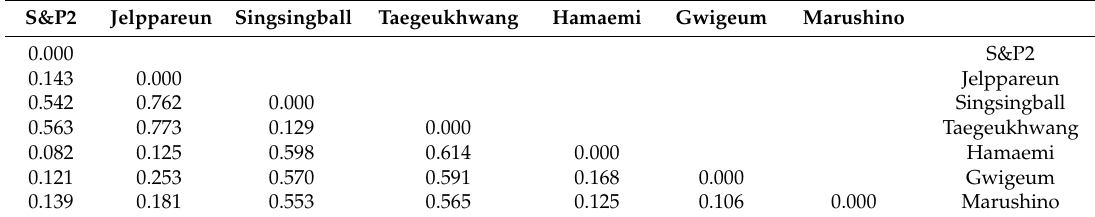
Table 4. Pairwise population matrix of Nei’s genetic distance.